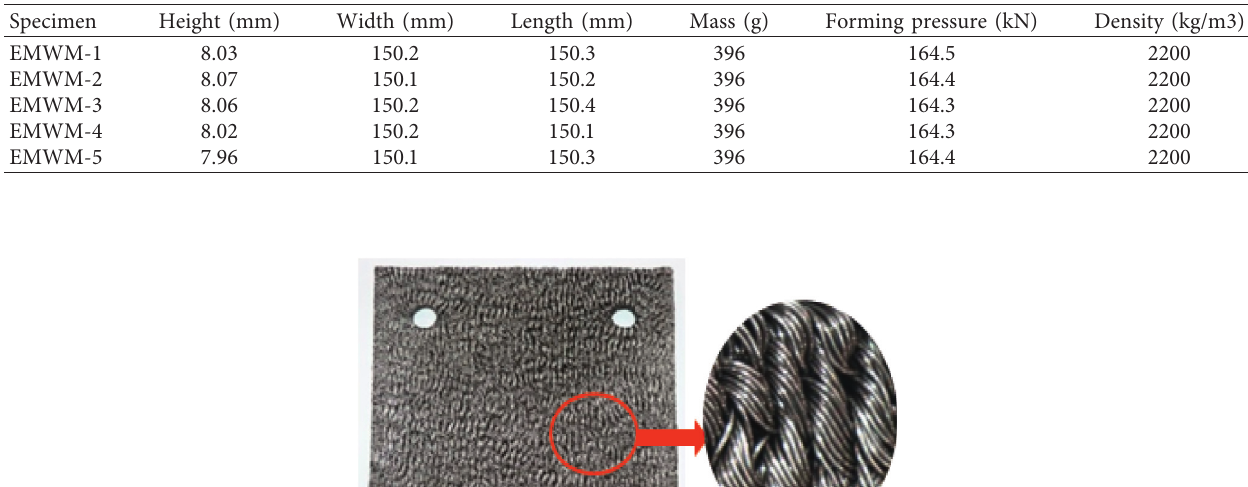
Table 3: The dimensions and structure parameters of EMWM samples.